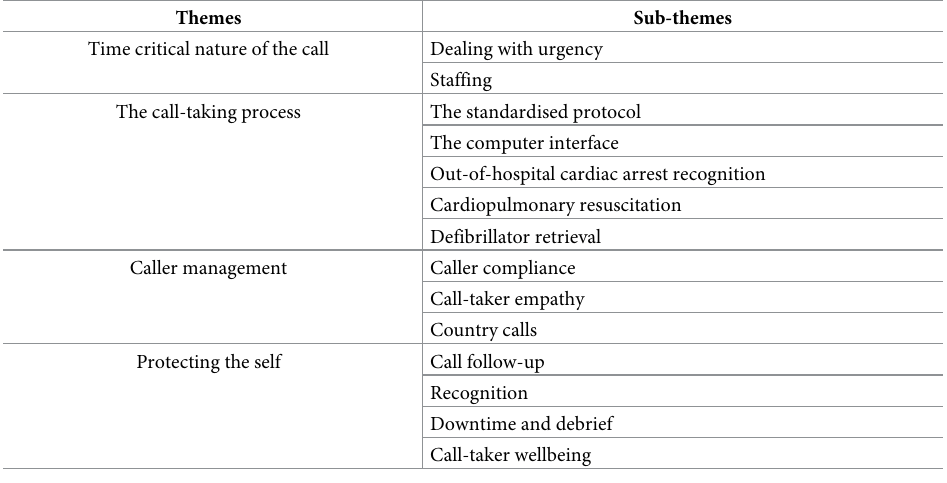
Table 1. Themes and sub-themes arising from call-taker